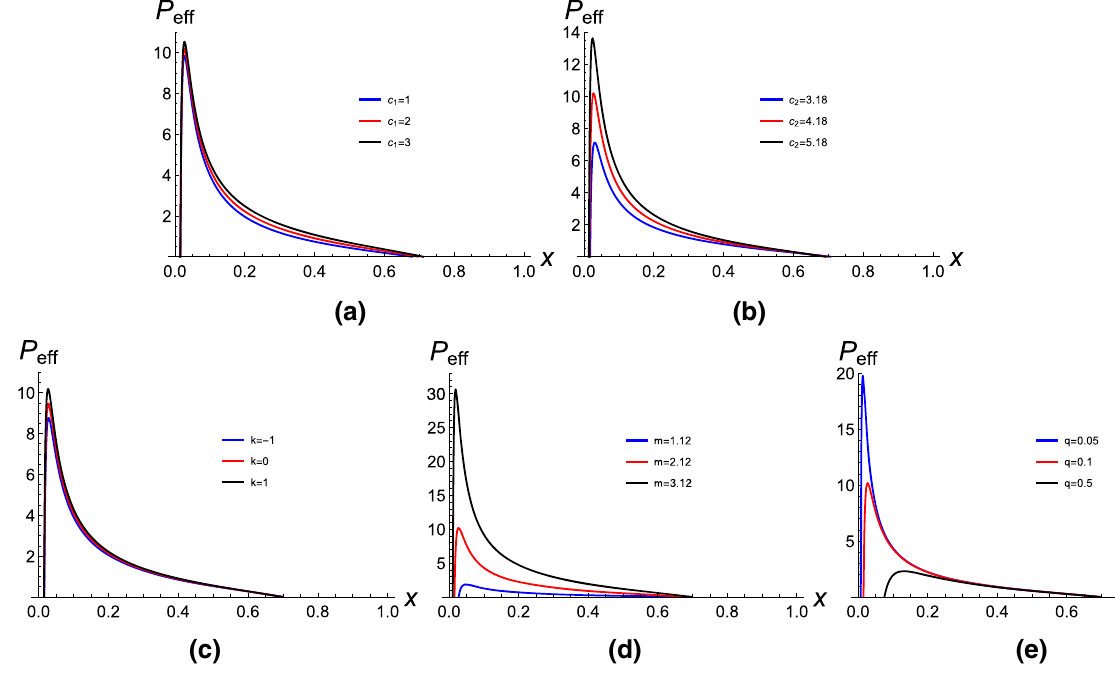
Fig. 1 P ef f − x diagrams when the parameters change respectively